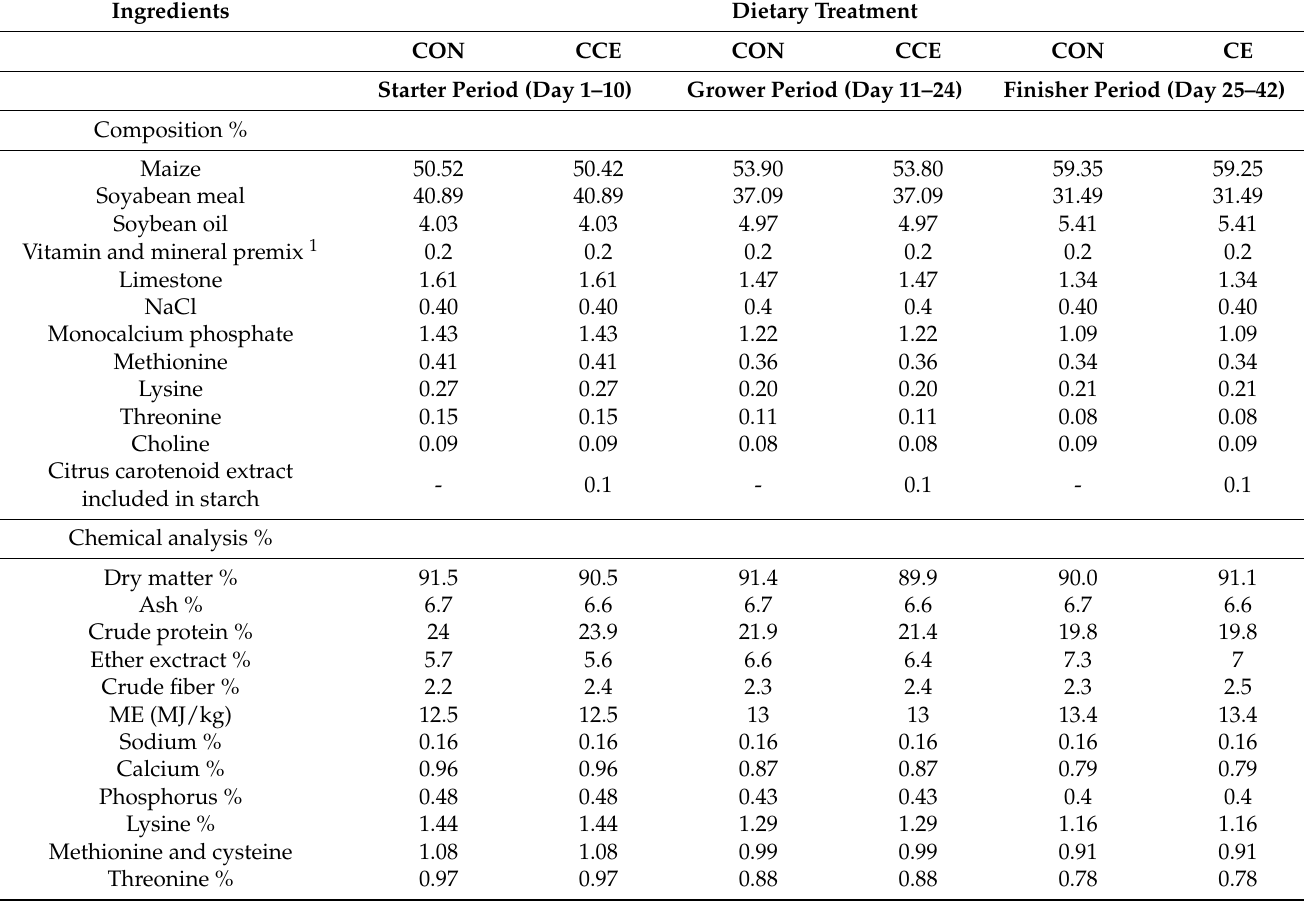
Table 2. Composition (%) and chemical analysis (%) of the starting (0–10 d), growing (11–24 d),